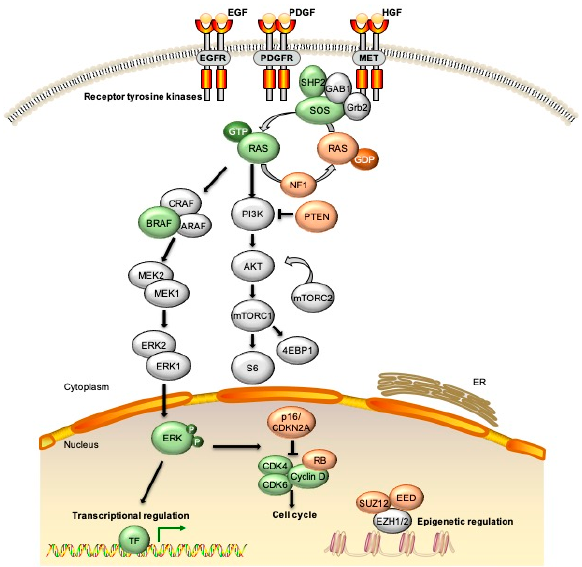
Figure 1. Signaling pathways altered due to genetic changes observed in malignant peripheral nerve sheath tumors (MPNST). The most common alterations in MPNST are loss of function of multiple tumor suppressors including NF1, p16 / CDKN2A, TP53, and SUZ12 / EED. Loss of NF1 , as well as epigenetic changes due to loss of PRC2 components, leads to increased signaling through the RAS / RAF / MEK and PI3K / AKT pathways. Additional molecular events observed in subsets of MPNST include mutations in BRAF , amplification of EGFR or MET receptor tyrosine kinases (RTKs), and changes to chromatin structure through mutations in alpha thalassemia / mental retardation syndrome X (ATRX) and other epigenetic modifiers. EGF / EGFR = epidermal growth factor / receptor; PDGF / PDGFR = platelet derived growth factor / receptor; HGF = hepatocyte growth factor; ERK = extracellular signal regulated kinase; CDK = cyclin dependent kinase; RB = retinoblastoma; TF = transcription factor; ER = endoplasmic